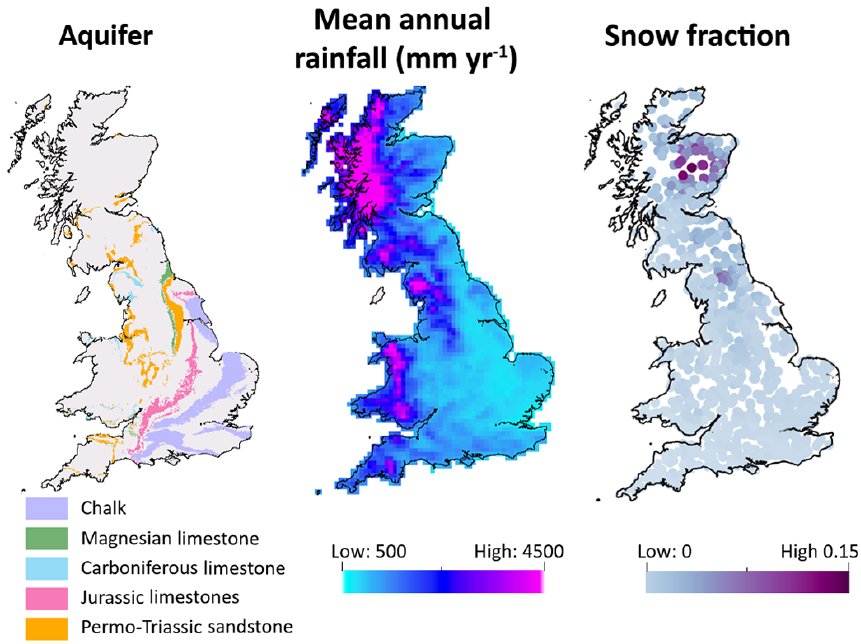
Figure 2. (a) Major aquifers across Great Britain, based on BSS Geology 625k, with the permission of the British Geological Survey. (b) Mean annual rainfall for 10km 2 rainfall grid cells across Great Britain. (c) Fraction of rainfall falling as snow for catchments across Great Britain, where a value of 0.15 indicates that 15% of the catchment precipitation falls on days when the temperature is below